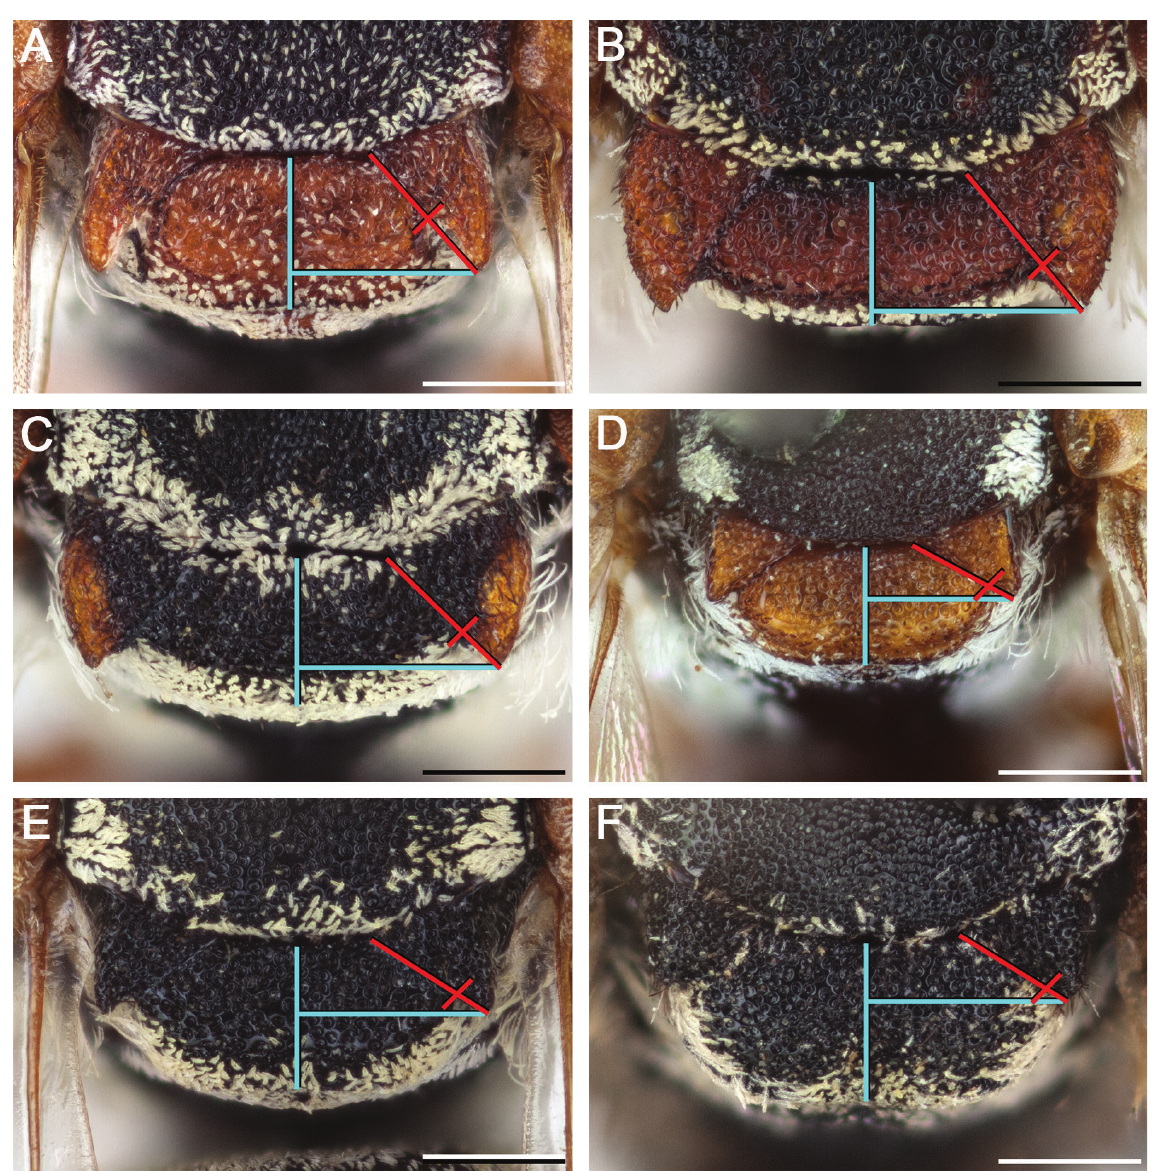
Fig. 21. Axillae and mesoscutellum of female, dorsal view. A . E. ainsliei Crawford, 1932. B . E. scutellaris Say, 1824. C . E. basili Onuferko, 2018, paratype. D . E. tessieris Onuferko, 2018, holotype. E . E. minimus (Robertson, 1902). F . E. asperatus Cockerell, 1910. Blue lines indicate the posterior extent of the axilla relative to the length of the mesoscutellum; red lines indicate the extent of the free portion of the axilla relative to its entire medial length. Scale bars = 0.5